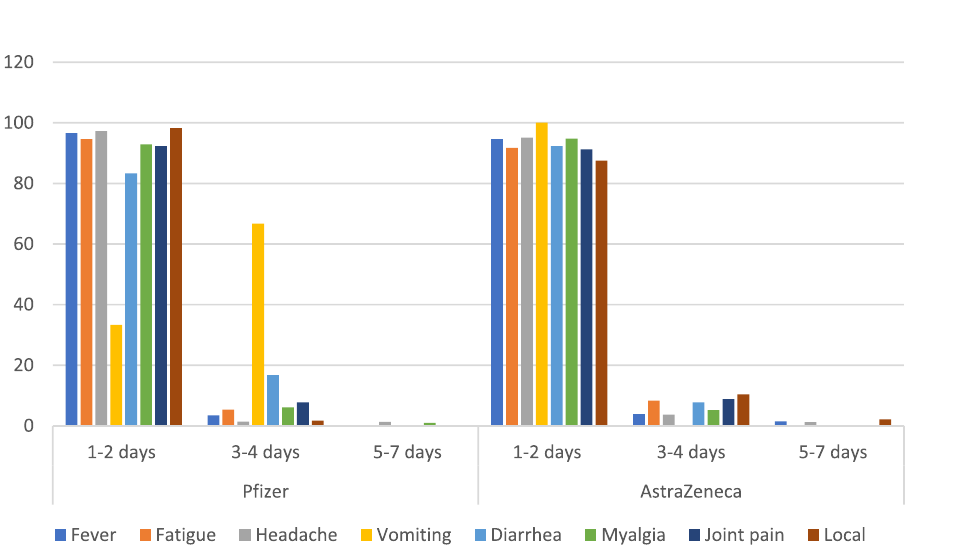
Figure 1. Onset of adverse events of studied vaccines among vaccinated